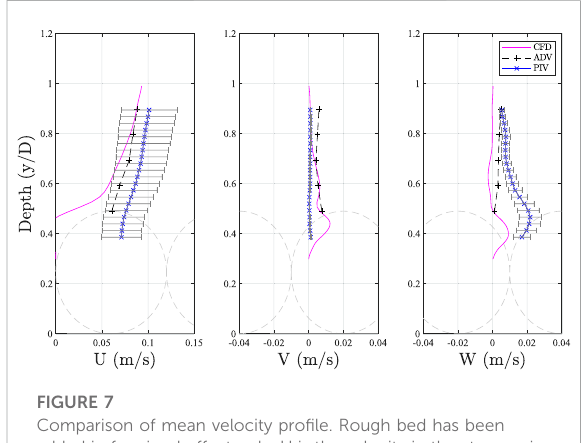
FIGURE 7 Comparison of mean velocity pro fi le. Rough bed has been added in for visual effect only. U is the velocity in the streamwise direction, V is the velocity in the vertical direction and W is velocity in the transverse or spanwise